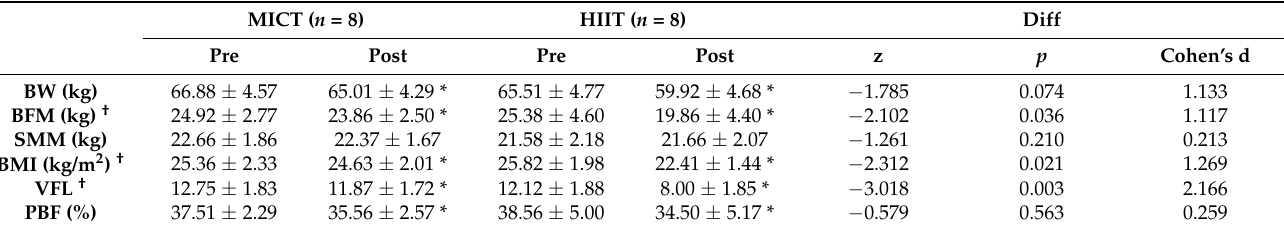
Table 3. Responses on body composition for MICT and HIIT